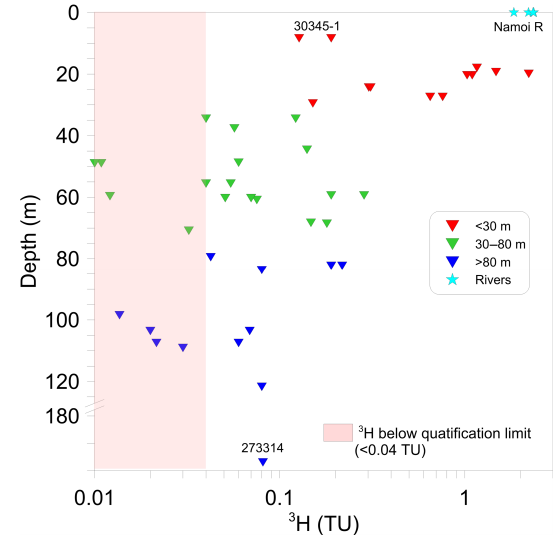
Figure 5. Plot of depth vs. 3 H, highlighting the 3 H activity through- out the vertical groundwater profile. Samples that fall within the pink zone on the left are below the quantification limit (<0.04TU). These data are not included in our interpretation of how 3 H changes with depth. They are presented to convey the relative proportions of interpretable versus non-interpretable